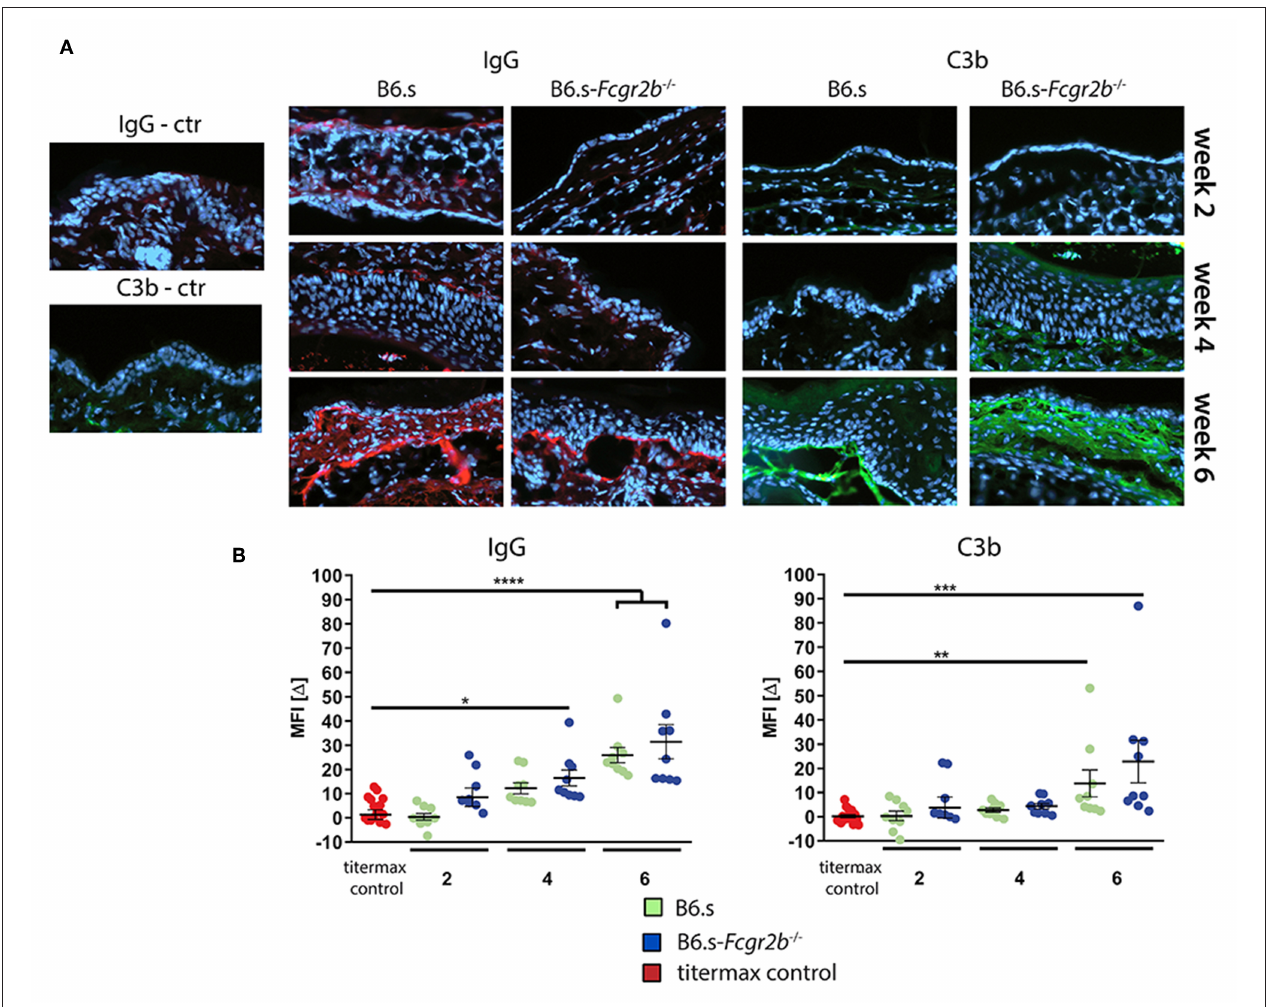
FIGURE 3 | Direct immunofluorescence staining showing the deposition of IgG aAbs and C3b in perilesional biopsies of ear skin from B6.s wt and B6.s- Fcgr2b − / − mice. (A) Linear deposits of murine IgG and C3b along the basal membrane zone. Representative immunofluorescence pictures of skin sections were taken at weeks 2, 4, and 6. Red = IgG aAb deposition; Green = C3b deposition. (B) Quantitative evaluation of IgG aAb and C3 deposition in B6.s wt and B6.s- Fcgr2b − / − mice. Microscopic pictures were analyzed via ImageJ software. The staining intensity of the basal membrane zone was measured, and a reference area of the epidermis was subtracted from it defining the intensity value MFI[ 1 ] for each sample in three different high-power fields; Data are shown as scattered dot plot with mean and standard error of the mean. Differences between groups were analyzed by non-parametric one-way ANOVA with post-hoc Dunn’s multiple comparisons test, (* p < 0.05,** p < 0.01,*** p < 0.001, and **** p <